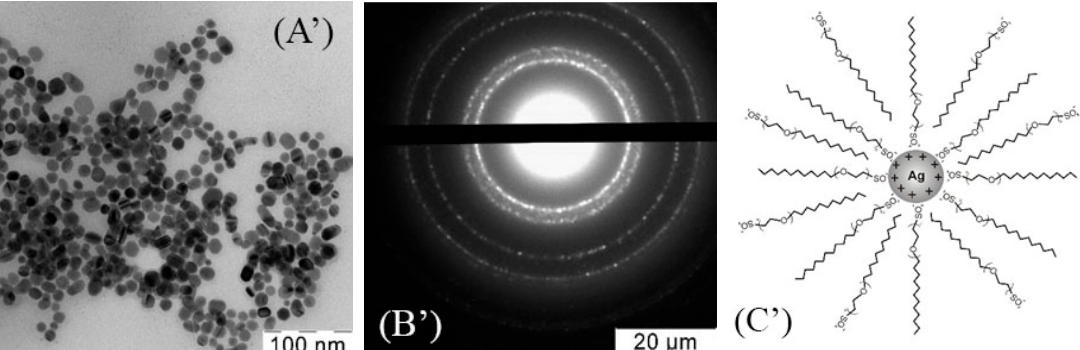
Figure 2. ( A ) The typical TEM images, ( B ) electron microdiffraction patterns, and ( C ) schematic representation of the stabilizing layer of the BDMMAC with glucose as the reducing agent and SLES-stabilized silver NPs ( A’ ), ( B’ ), ( C’ ).